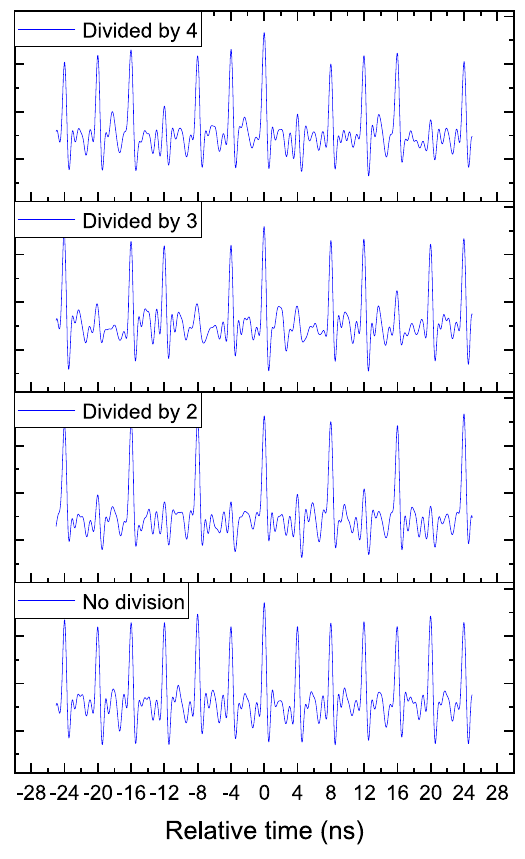
Fig. 4. Oscilloscope traces of the signal (same for idler) pulse train in different repetition rate division configurations in the dual-seeded